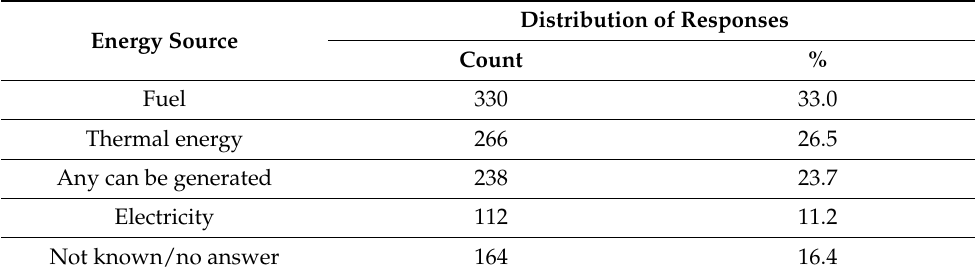
Table 6. Knowledge of energy sources that can be generated by biogas ( N = 1002).